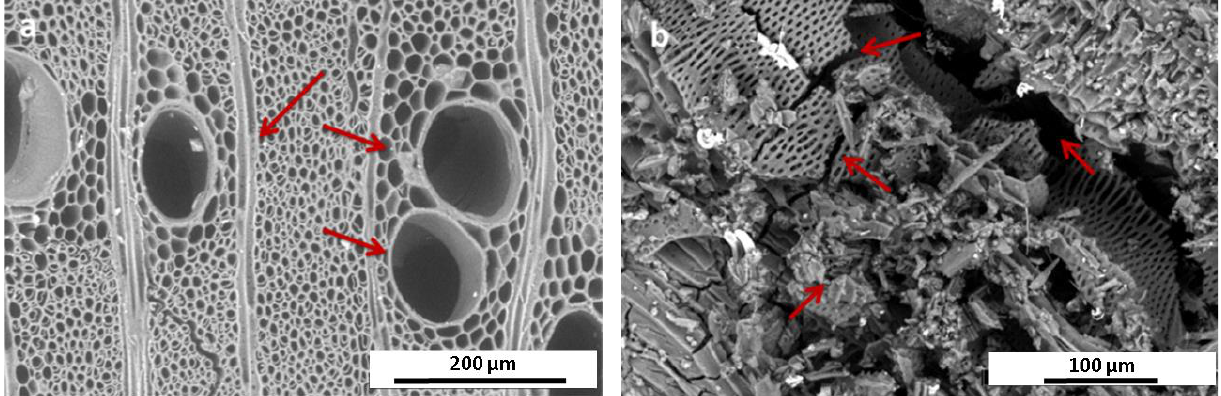
Figure 6. ( a ) SEM image of the Acacia standard wood sample (magnification 600 × ); red arrows indicate the homogeneous structure of wood cell walls. ( b ) SEM image of the sample #1 (Pure core wooden sample; magnification 800 × ). The red arrows indicate the strongly fragmented wood structure.